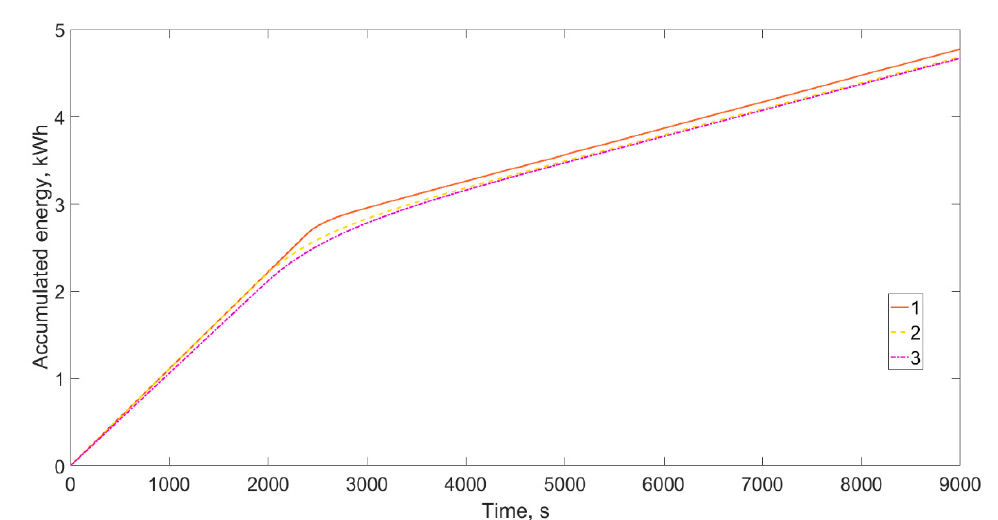
Figure 14. Total energy usage for control systems in the presence of a random noise signal with a maximum amplitude of 3% for the different controllers: 1—relay and 2—PID, 3—I-PD.